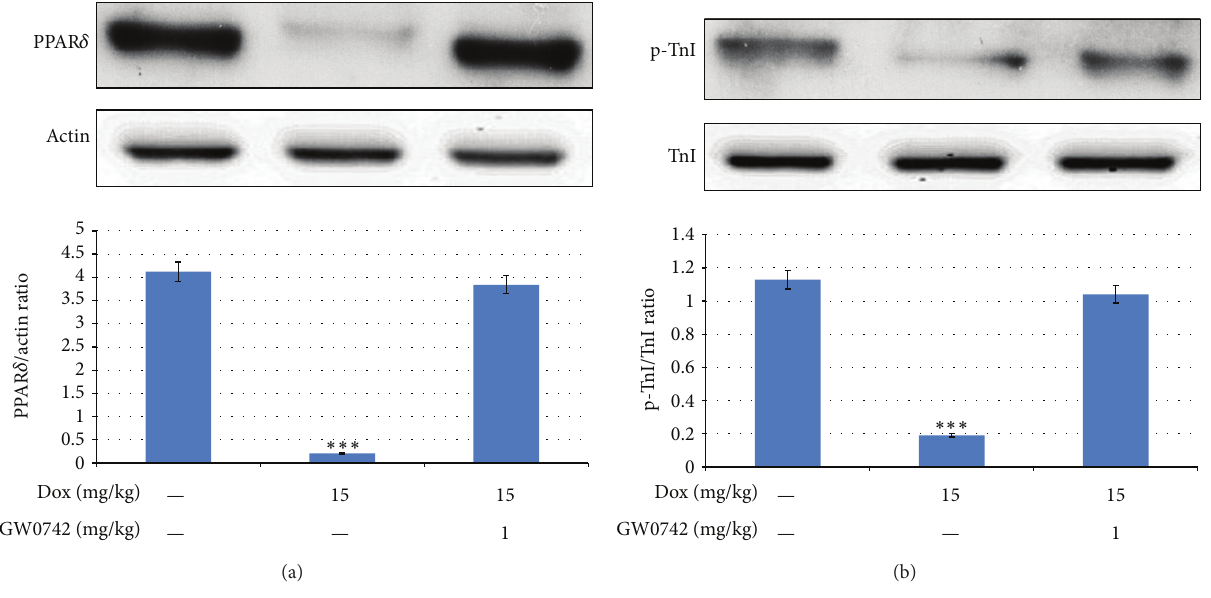
Figure 1: PPAR 𝛿 expression and TnI phosphorylation in hearts from DOX-treated rats, GW0742-added DOX-treated rats, or Wistar rats. Changes in cardiac PPAR 𝛿 protein expression (a) and the levels of cardiac TnI phosphorylation (b) were examined in age-matched Wistar rats (control rats), DOX-treated rats, and GW0742-added DOX-treated rats. All values are expressed as mean ± SEM ( 𝑛 = 6 per group). ∗ 𝑃 < 0.05 and ∗∗ 𝑃 < 0.01 as compared with Wistar rats.